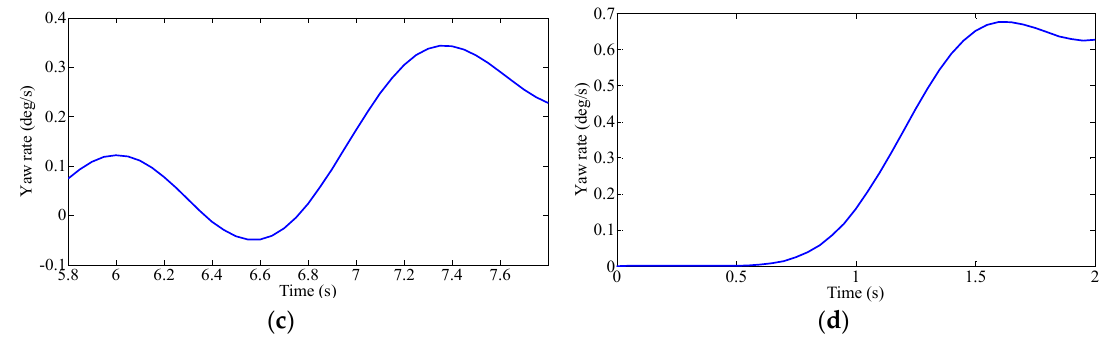
Figure 9. Yaw rate under different steering conditions: ( a ) turning right; ( b ) U-turn; ( c ) lane keeping; ( d ) lane changing.